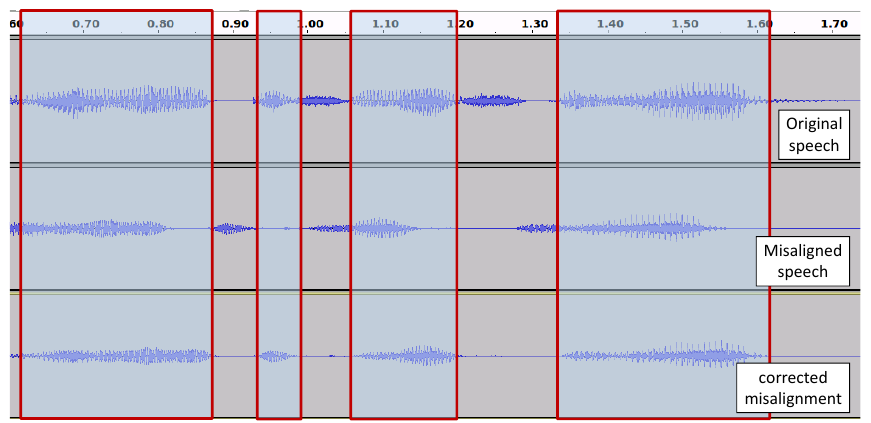
Figure 3. Misalignment correction with proposed Euclidean-distance-based